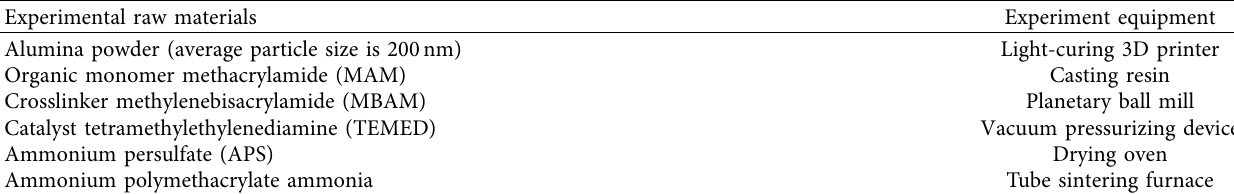
Table 1: Experimental materials and equipment